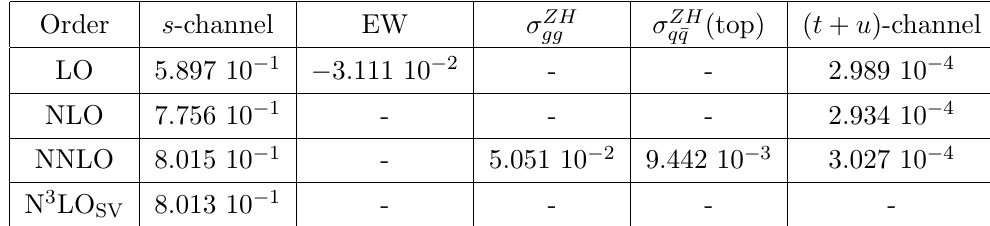
Table 1 . QCD and electroweak (EW) contributions to ZH production at the LHC with cen- ter of mass energy 13 TeV. The (cid:27) ZH refers to the contribution coming from the gluon initiated gg sub-processes. The top quark loop contribution is denoted by (cid:27) ZH (top). The ( t + u )-channel con- q (cid:22) q tribution at NNLO is under the SV approximation. All the numbers of the cross-sections are in unit